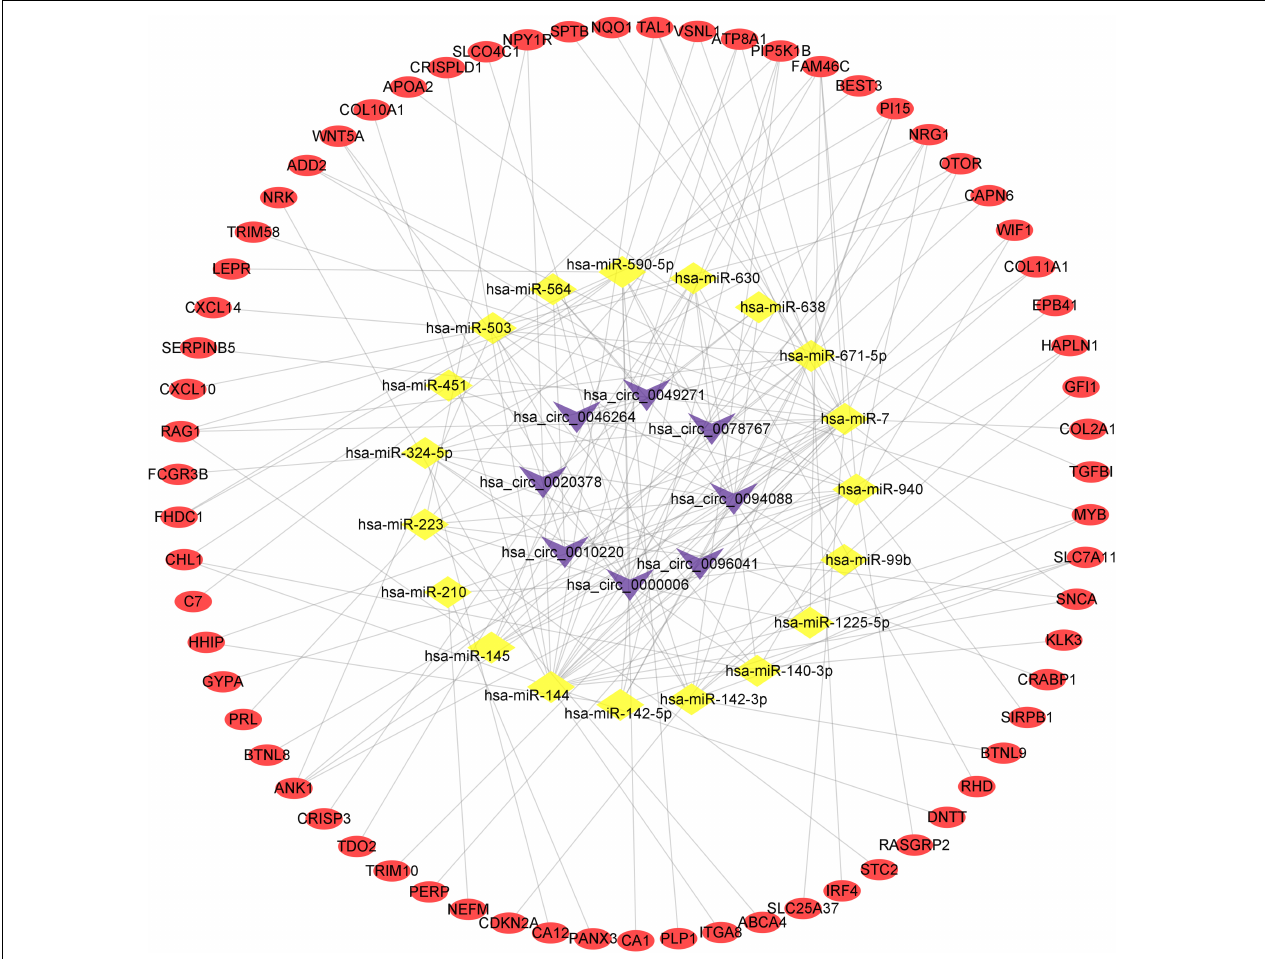
FIGURE 5 | The circRNA-miRNA-mRNA regulatory network. The purple V represents circRNAs, the yellow diamond represents miRNAs and the red oval represents mRNAs.